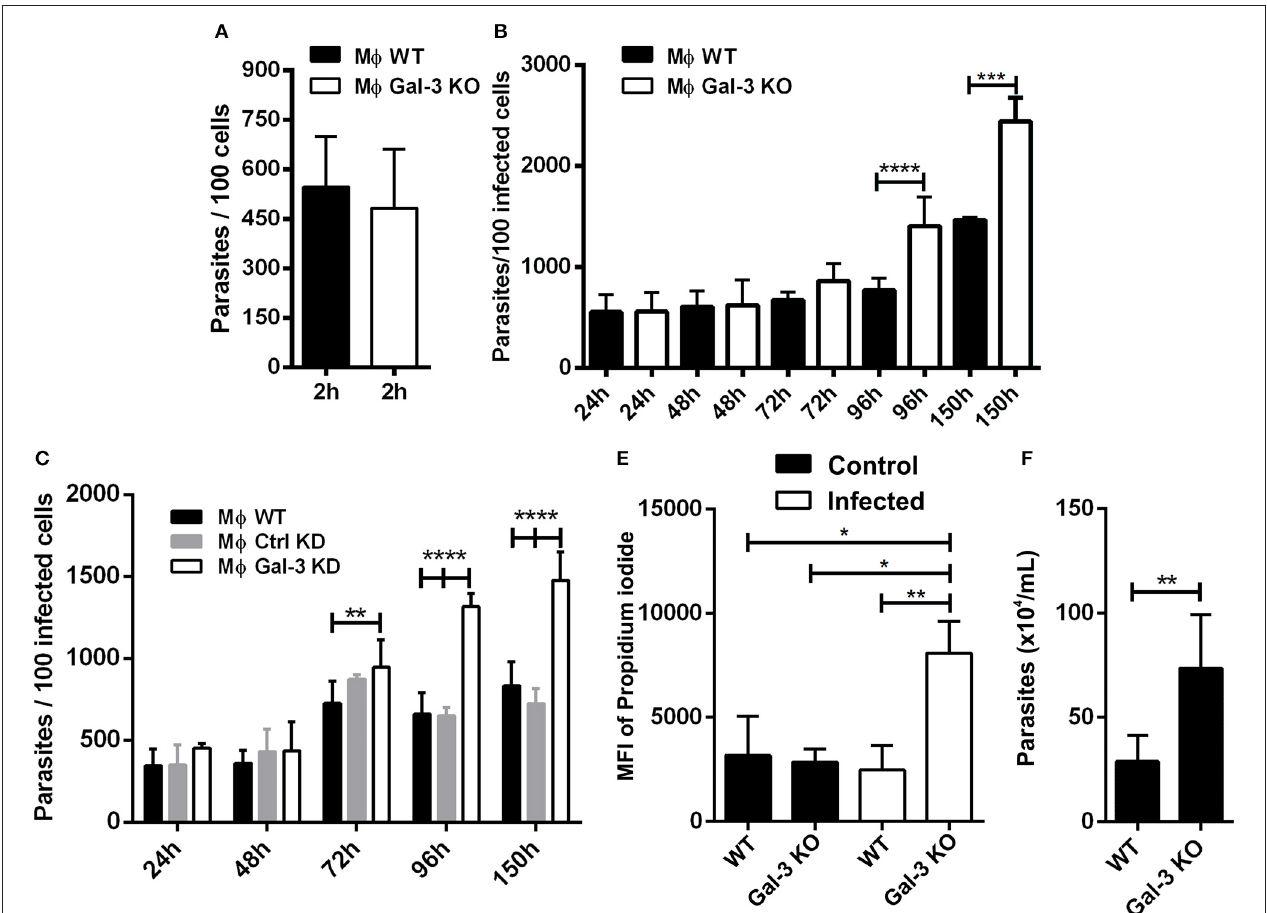
FIGURE 1 | Lack of Gal-3 increased parasite replication and host cell lyses. Mouse peritoneal macrophages were plated and submitted to invasion. At 2h after invasion and additional later time points, coverslips were washed, fixed with Bouin, and stained with Giemsa. For invasion analysis after 2h of infection was counted the number of parasites in 100 infected peritoneal macrophages (A) . The number of parasites in 100 peritoneal macrophages (B) and in 100 iMo/B6 cells (C) was counted after 24, 48, 72, 96, and 150h of infection. The percentage of lysed cells was determined by the nuclear incorporation of propidium iodide by flow cytometry (D) . The number of parasite released in the supernatant of infected macrophages at 96h post-infection was counted (E) . Comparisons between WT and Gal-3 KO were performed by using Kruskal–Wallis and Dunn’s multiple comparisons test. * p < 0.05, ** p < 0.01, *** p < 0.001, **** p < 0.0001.